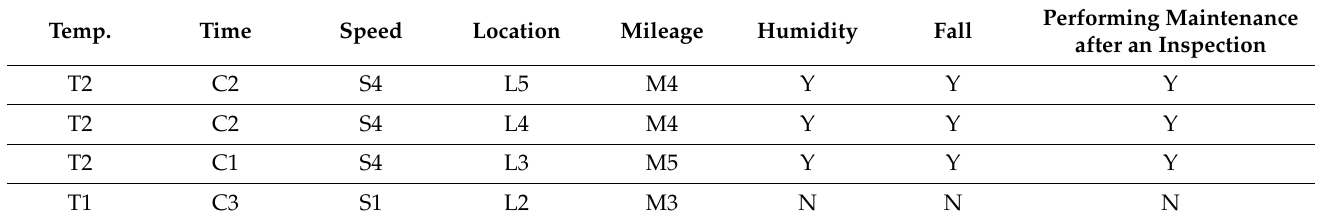
Table 10. Data pre-processing data